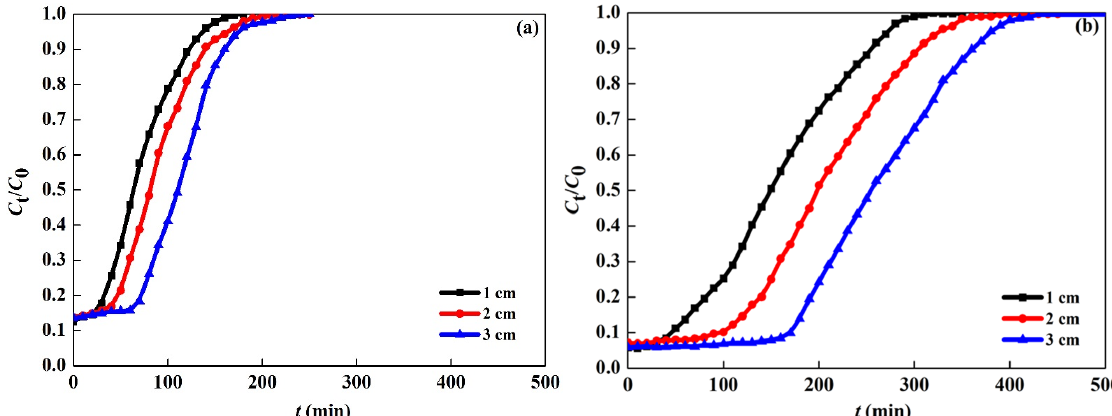
Figure 7. Effect of different column heights on NAP adsorption onto O-SAC1 ( a ) and O-PCAC1 ( b ) at a concentration of 30 mg/L and flow rate of 2 mL/min.